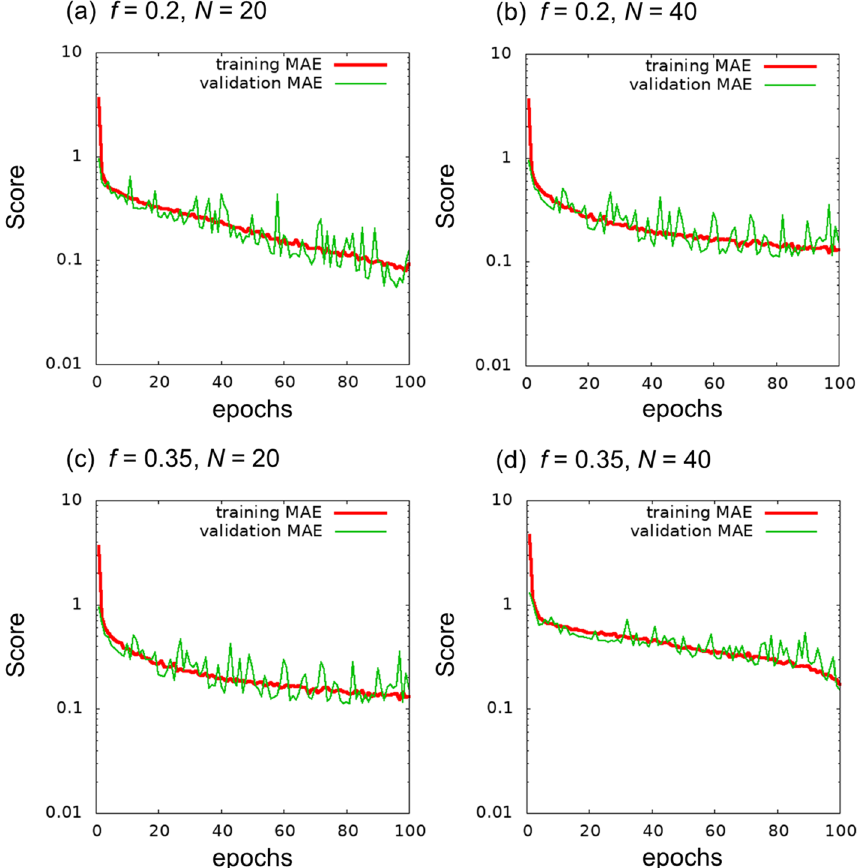
Figure 6. Learning curves of the regression problem with the 4-class teaching